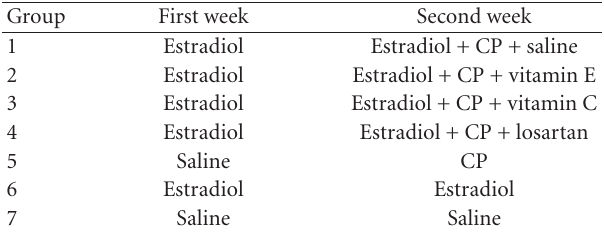
Table 1: Summary of the treatment in the groups. Estradiol was injected at the beginning of each week. CP was administrated as a single dose at the beginning of the second week. The vitamins and losartan were injected daily during the second